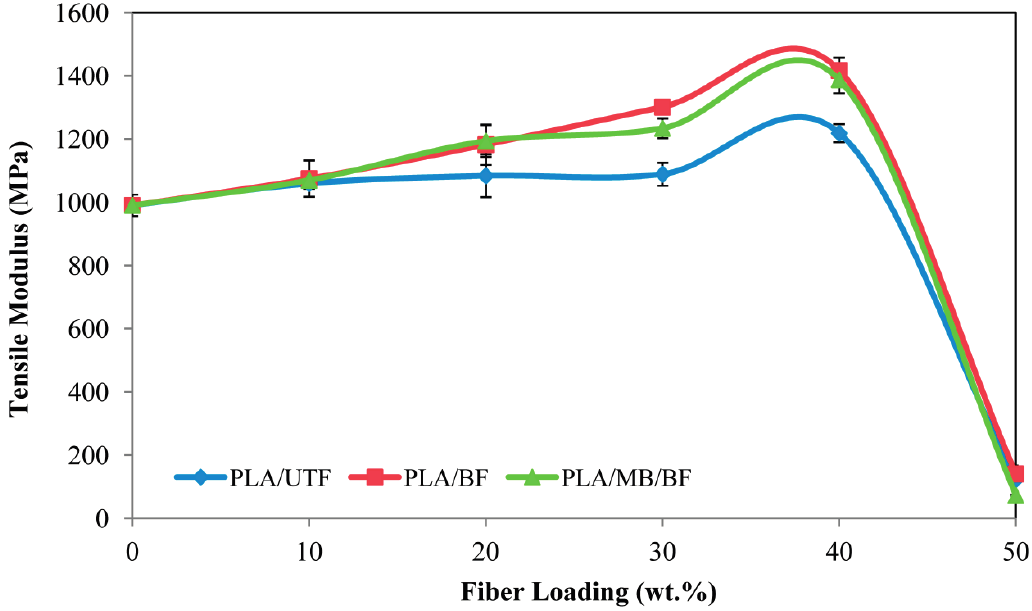
Figure 7. Tensile modulus of PLA/UTF, PLA/BF and PLA/MB/BF